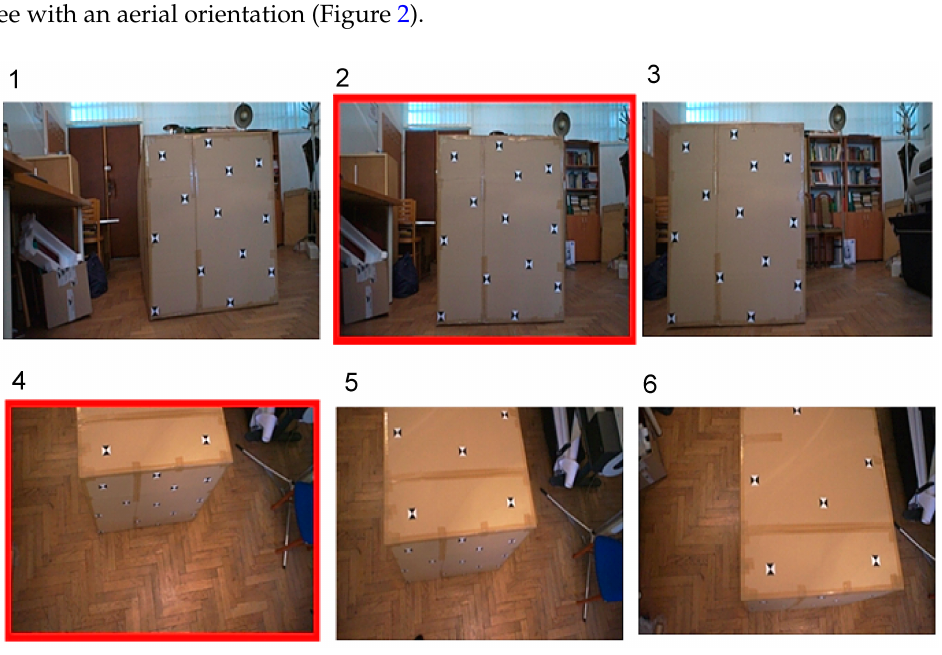
Figure 2. Test object video frames acquired from the simulated terrestrial level (frames 1 – 3 ) and aerial level (frames 4 – 6 ) Images number 2 and 4 are framed in red because for this pair of images, it is possible to conduct an absolute orientation when difference of tilt angle is near 90°.